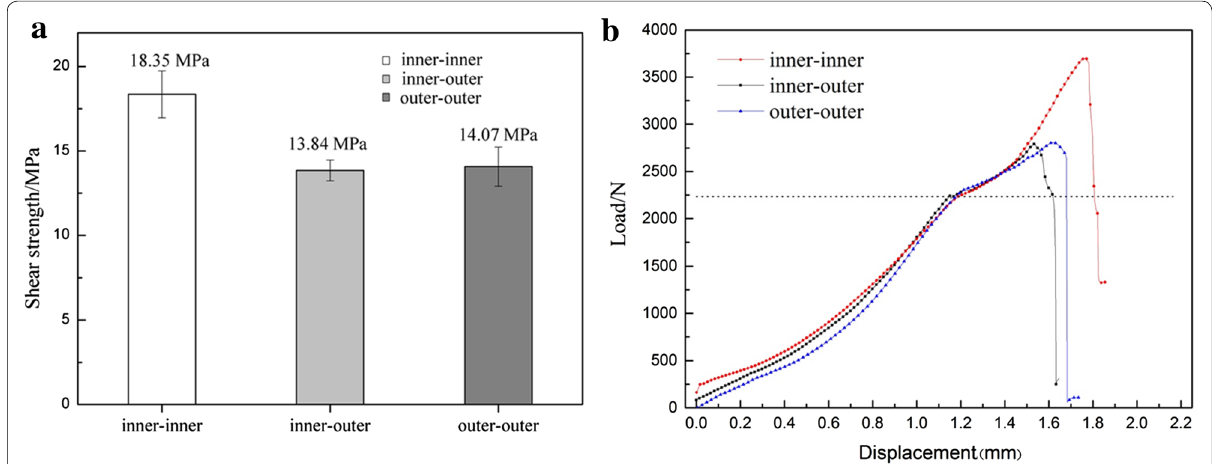
Fig. 4 a Shear strength results of the three types of glued bamboo strips; b load–displacement curve of compression shear